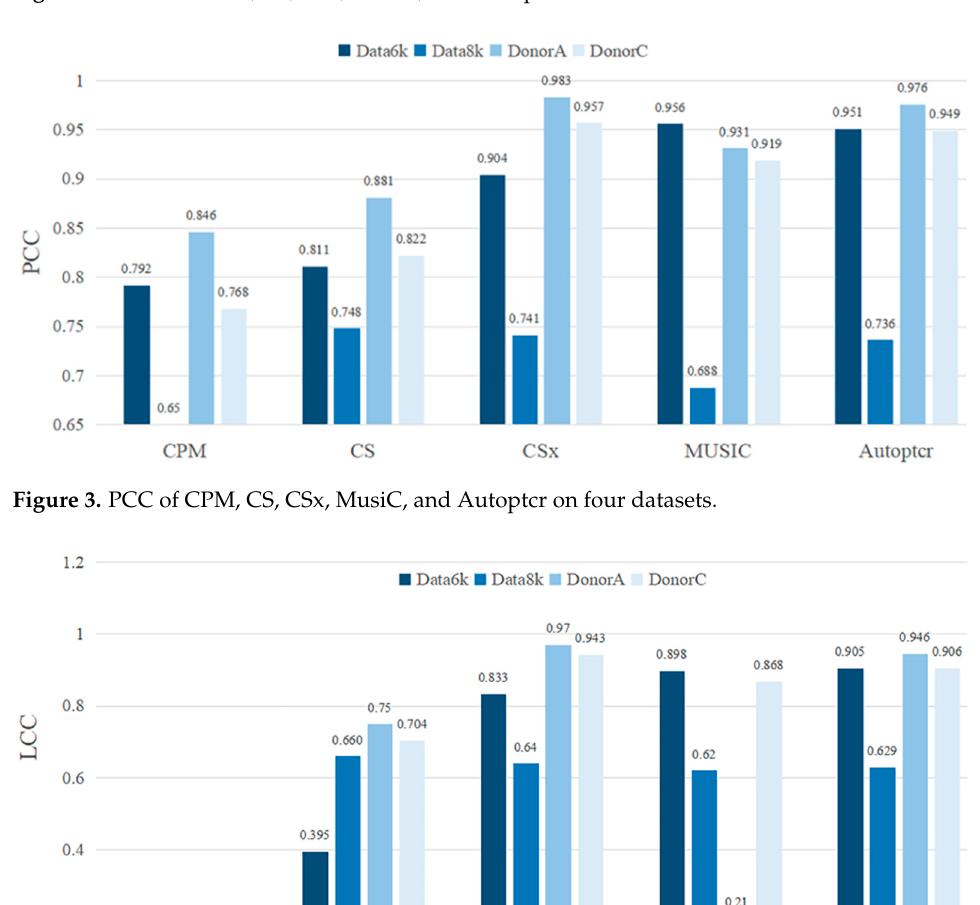
Figure 2. RMSE of CPM, CS, CSx, MusiC, and Autoptcr on four datasets.